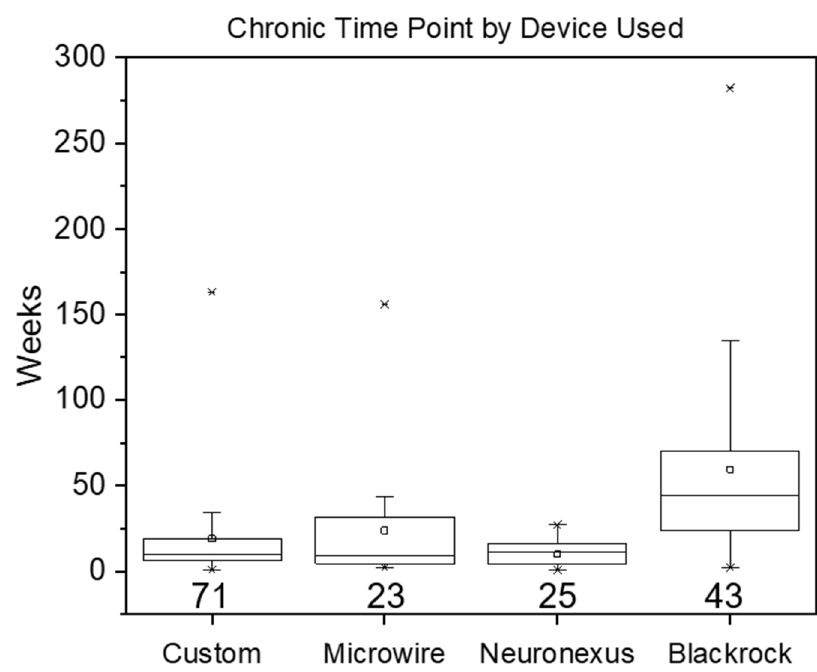
Figure 2. Chronic durations based on implanted device. The box is determined by the 25th and 75th percentiles while the 75th percentiles while the whiskers indicate 1.5 times the interquartile range. The minimum and whiskers indicate 1.5 times the interquartile range. The minimum and maximum are represented by asterisks while the maximum are represented by asterisks while the horizontal line and small square within the box horizontal line and small square within the box indicate the median and mean respectively. The numbers below each box indicate the median and mean respectively. The numbers below each box and whisker plot reflect and whisker plot reflect the number of studies contributing to the plot. the number of studies contributing to the